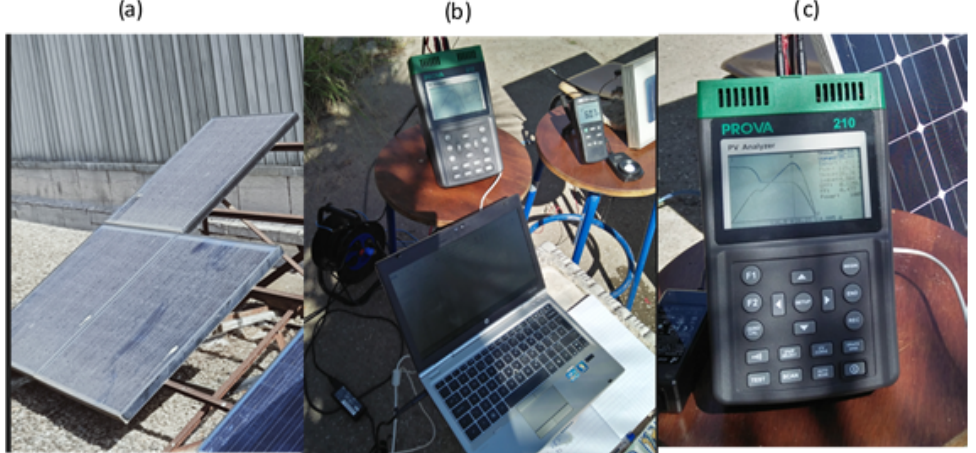
Figure 2. ( a ) The PV array under study, ( b ) test facility, and ( c ) Prova I–V tracer.